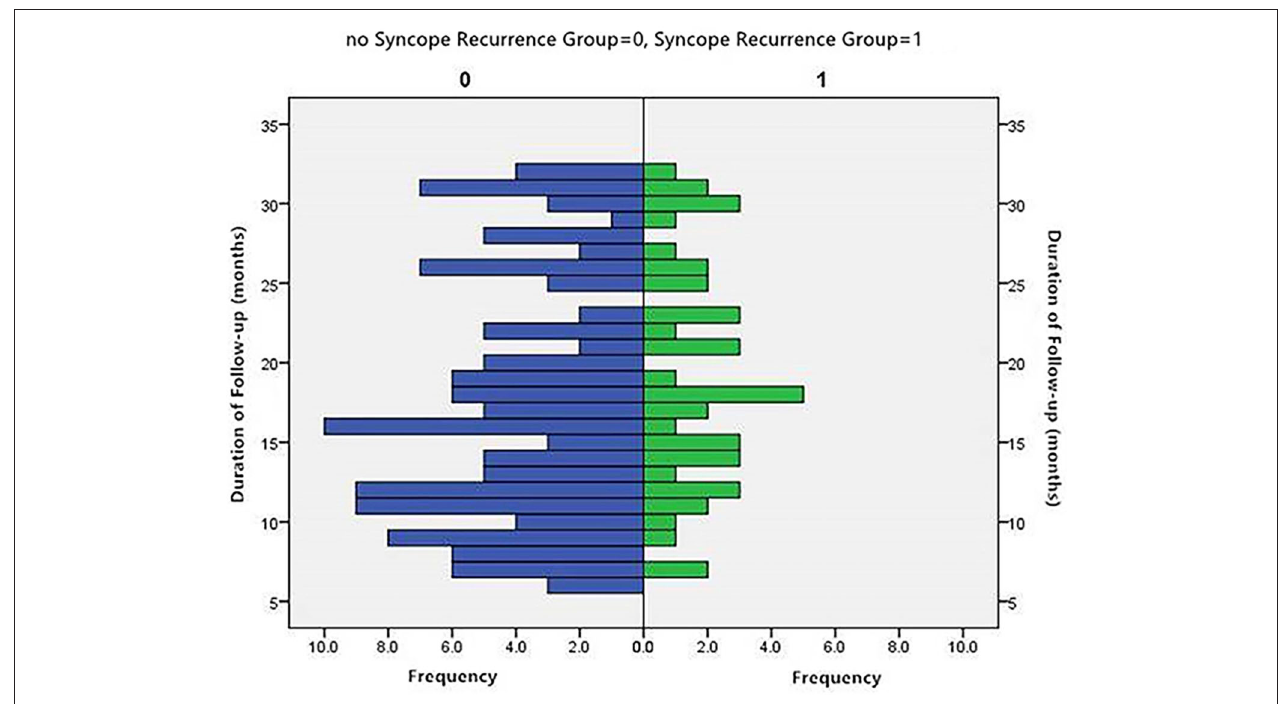
FIGURE 2 | Distribution of patients by months of follow-up.